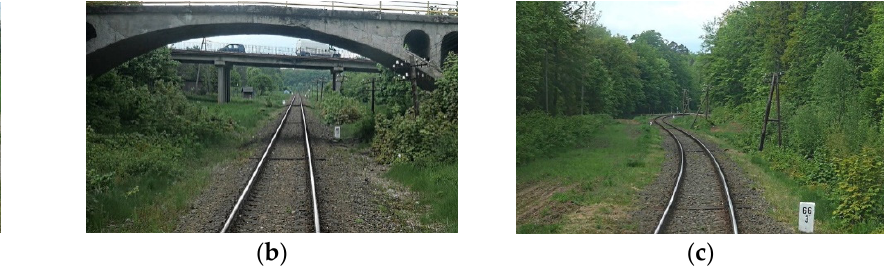
Figure 2. Views of sections of railway line no. 211: ( a ) open area along initial section; ( b ) viaducts in central section; ( c ) final woodland section.